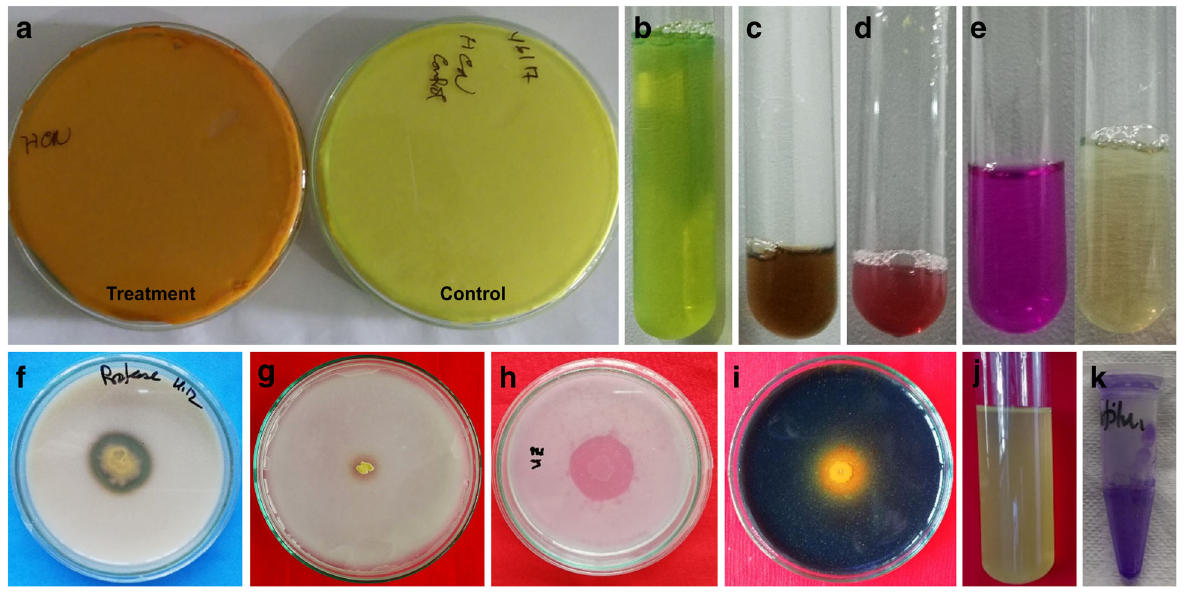
Fig. 2 Antagonistic, enzymatic, and plant growth-promoting potentials of isolate BA5. a HCN production, b siderophores obtained as cell-free culture filtrate, c FeCl activity, i organic acid production, j ammonia production, and k biofilm formation in plastic Eppendorf